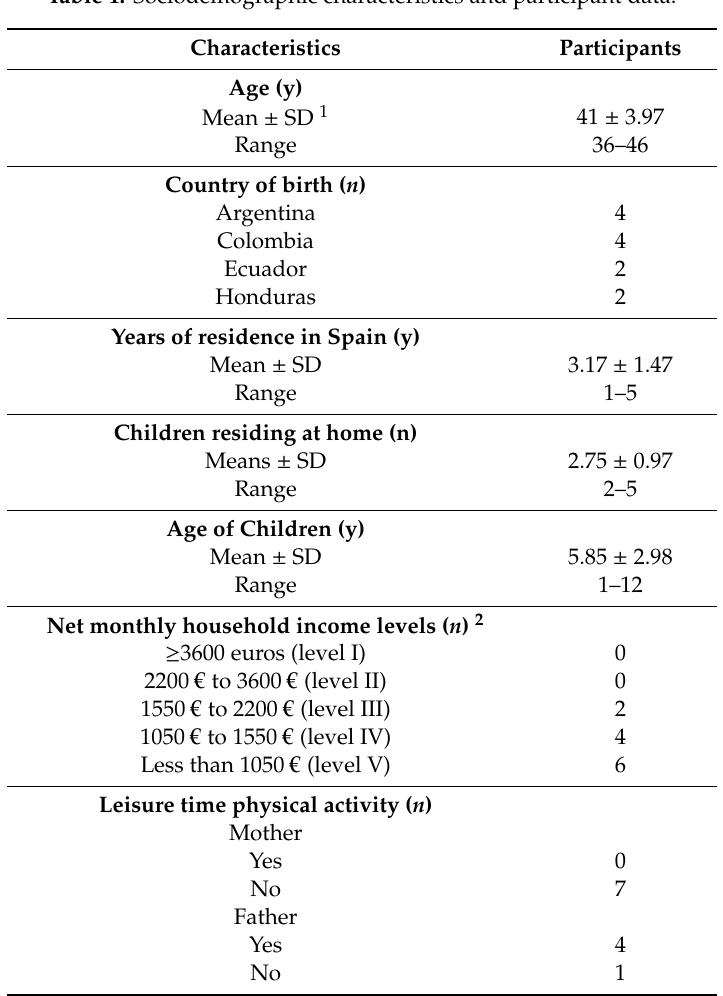
Table 1. Sociodemographic characteristics and participant